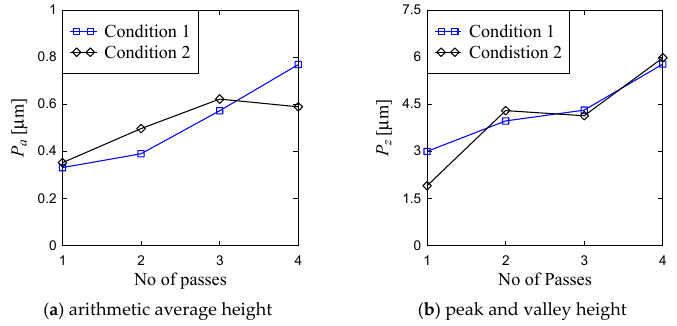
Figure 13. Roughness of the primary profiles.